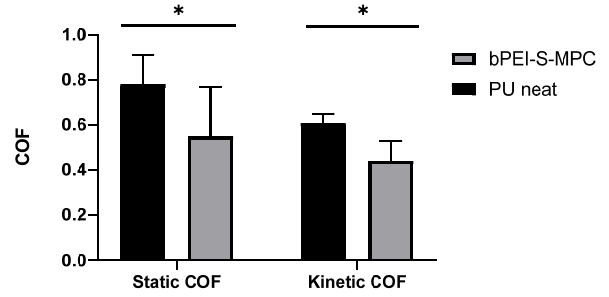
= 50, * denotes p < 0.01).